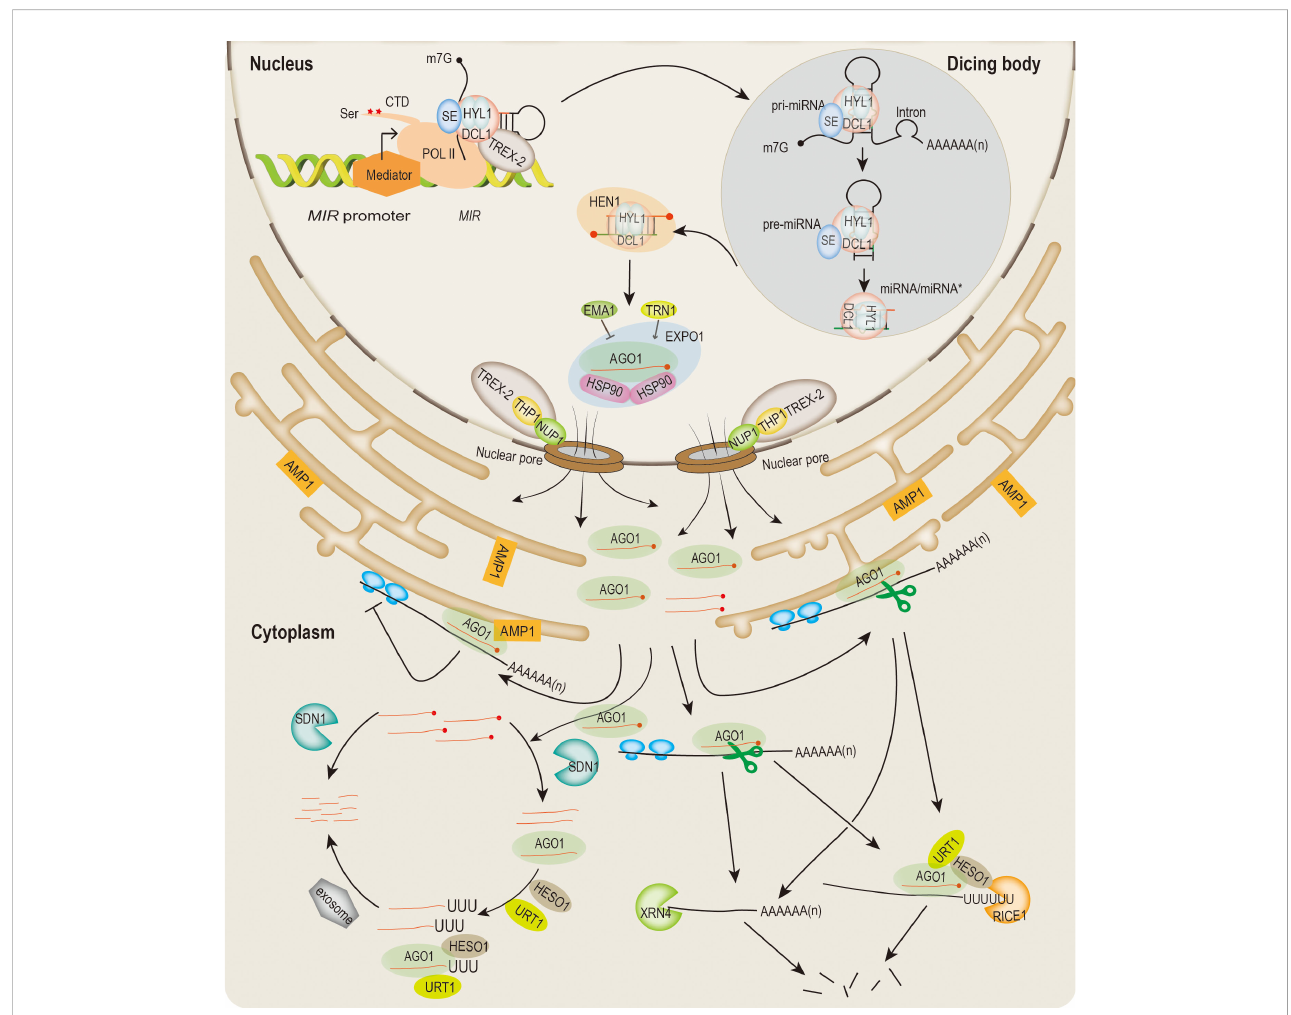
FIGURE 1 Overview of miRNA biogenesis, miRISC assembling and export, and modes of action in plants. MIR genes are transcribed by POL II and regulated by multiple cotranscriptional regulators (such as mediator, DCL1 complex, TREX-2, ect.). The C-terminus of POL II can be phosphorylated by kinases during the transcription process. Pri-miRNA is processed at the dicing bodies (DCL1, HYL1 and SE). Pre-miRNA is subsequently processed by DCL1 into an imperfect miRNA/miRNA* duplexes. HEN1 methylates the 3 ’ end of the miRNA/miRNA*. Mature miRNAs are loaded into AGO1 protein in the nucleus. MiRISCs are exported into the cytoplasm through a CRM1 (EXPO1)/NES-dependent manner via the TREX-2/NUP1 facilitation pathway. EMA1 and TRN1 can negatively and positively regulate miRNA loading, respectively. Translocation of miRNAs from the nucleus to the cytoplasm directs target transcript cleavage and translation repression. AGO1 mediates cleavage of miRNA targets sequences, and followed by degradation of cleaved fragments. Translation repression occurs on membrane-bound polysomes (MBPs), and requires endoplasmic reticulum (ER)-localized AMP1. Degradation of miRNA begins with the removal of the methyl group at the 3 ’ end by the SDN1 family of 3 ’ -5 ’ exonucleases, followed at 3 ’ end uridylation by the nucleotidyl transferases HESO1 and/or URT1. In addition, SDN1 and HESO1/URT1 can act on both AGO-bound miRNAs and free miRNAs in the cytoplasm. Free miRNAs are also degraded by SDN1 directly. For the target mRNAs cleaved by miRISC, RICE1 is responsible for degrading the uridylated target mRNA 5 ’ fragment. The 5 ’ -3 ’ exonuclease XRN4 can degrade the 3 ’ fragment of target